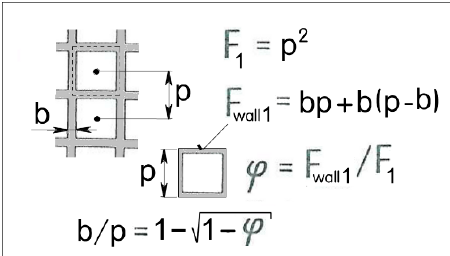
Figure 4. Other important factors (apart from those in Figure 3) used to characterize available flowpath area in a matrix is the cell pitch p and matrix wall thickness b.